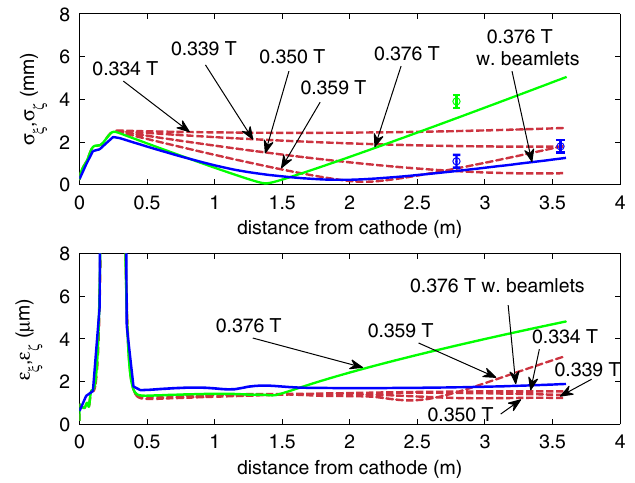
FIG. 9. (Color) Simulations of transverse rms beam size (top) and emittance (bottom) of the central beamlet along the z axis for different values of L3 peak axial magnetic field ^ B 2 ½ 0 : 339 ; 0 : 376 (cid:4) T (dashed red lines). The cases shown in Fig. 6 correspond to the blue (with surrounding beamlets) and green (without surrounding beamlets) solid lines. The corresponding data measured at YAG1 and YAG2 are also shown as dots with the same color coding convention as the